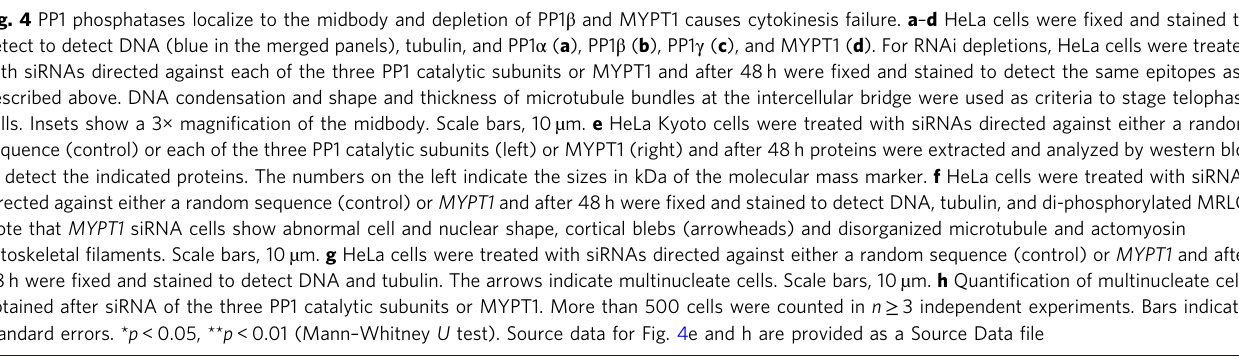
Fig. 4 PP1 phosphatases localize to the midbody and depletion of PP1 β and MYPT1 causes cytokinesis failure. a – d HeLa cells were fi xed and stained to detect DNA (blue in the merged panels), tubulin, and PP1 α ( a ), PP1 β ( b ), PP1 γ ( c ), and MYPT1 ( d ). For RNAi depletions, HeLa cells were treated with siRNAs directed against each of the three PP1 catalytic subunits or MYPT1 and after 48 h were fi xed and stained to detect the same epitopes as described above. DNA condensation and shape and thickness of microtubule bundles at the intercellular bridge were used as criteria to stage telophase cells. Insets show a 3× magni fi cation of the midbody. Scale bars, 10 µ m. e HeLa Kyoto cells were treated with siRNAs directed against either a random sequence (control) or each of the three PP1 catalytic subunits (left) or MYPT1 (right) and after 48 h proteins were extracted and analyzed by western blot to detect the indicated proteins. The numbers on the left indicate the sizes in kDa of the molecular mass marker. f HeLa cells were treated with siRNAs directed against either a random sequence (control) or MYPT1 and after 48 h were fi xed and stained to detect DNA, tubulin, and di-phosphorylated MRLC. Note that MYPT1 siRNA cells show abnormal cell and nuclear shape, cortical blebs (arrowheads) and disorganized microtubule and actomyosin cytoskeletal fi laments. Scale bars, 10 µ m. g HeLa cells were treated with siRNAs directed against either a random sequence (control) or MYPT1 and after 48 h were fi xed and stained to detect DNA and tubulin. The arrows indicate multinucleate cells. Scale bars, 10 µ m. h Quanti fi cation of multinucleate cells obtained after siRNA of the three PP1 catalytic subunits or MYPT1. More than 500 cells were counted in n ≥ 3 independent experiments. Bars